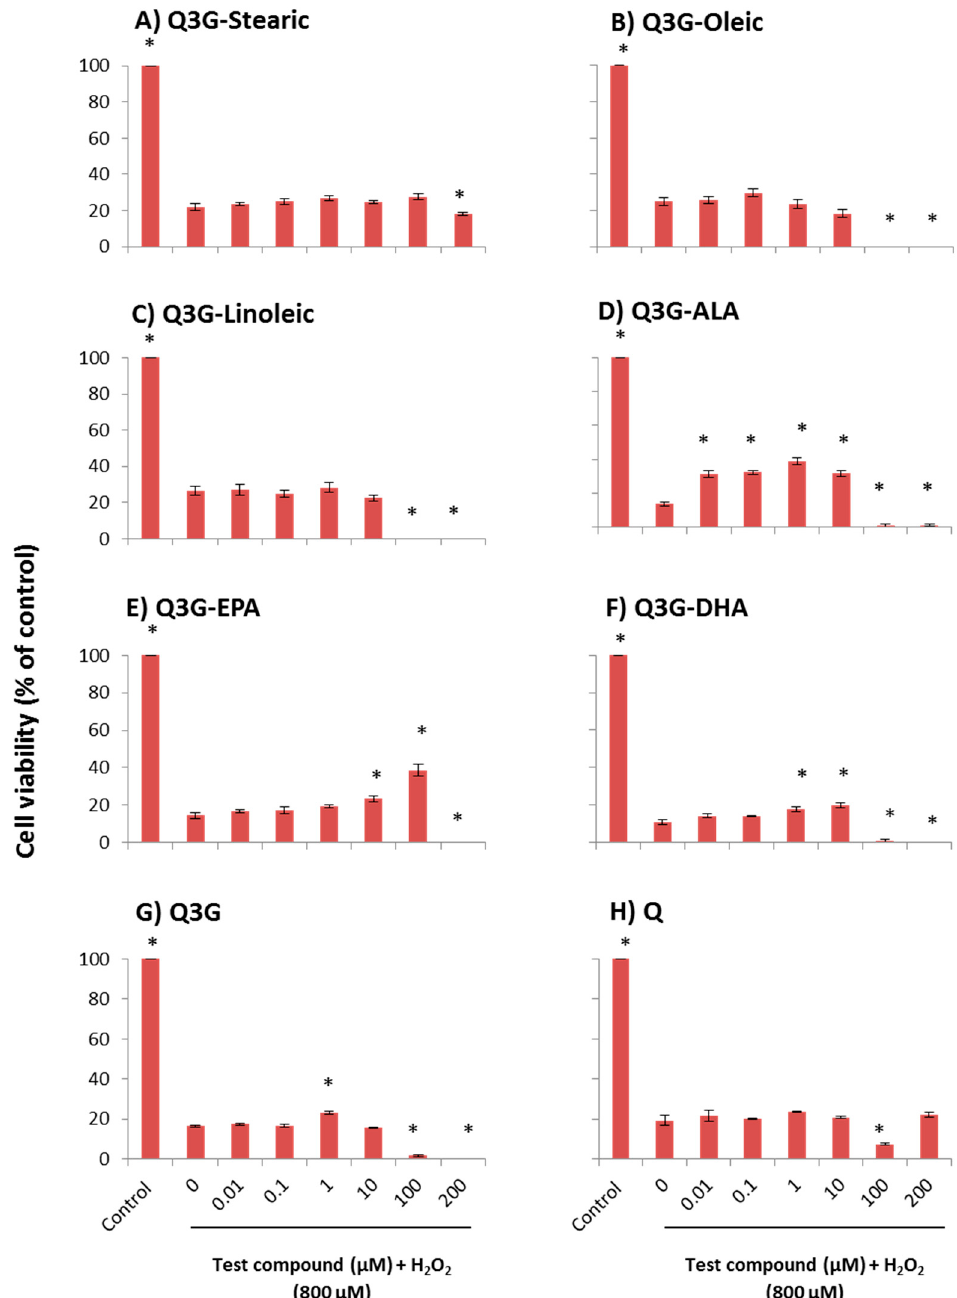
Figure 2. Dose-dependent cytoprotective effect of test compounds against H 2 O 2 -induced cytotoxicity in WI-38 cells. ( A ) Stearic acid ester of Q3G; ( B ) Oleic acid ester of Q3G; ( C ) Linoleic acid ester of Q3G, ( D ) ALA ester of Q3G; ( E ) EPA ester of Q3G; ( F ) DHA ester of Q3G; ( G ) Q3G and ( H ) Quercetin (Q). Cells were pre-incubated for 48 h followed by incubation with 800 µM H 2 O 2 for 3 h. Cell viability is presented as percentage related to the control. Control contains cells with no incubation of test compounds and no oxidative injury. Data are expressed as mean ± SEM ( n = 6). * p ≤ 0.05, significantly different from model group. The cells in the model group were subjected to oxidative injury by H 2 O 2 , but not treated with any test compounds.